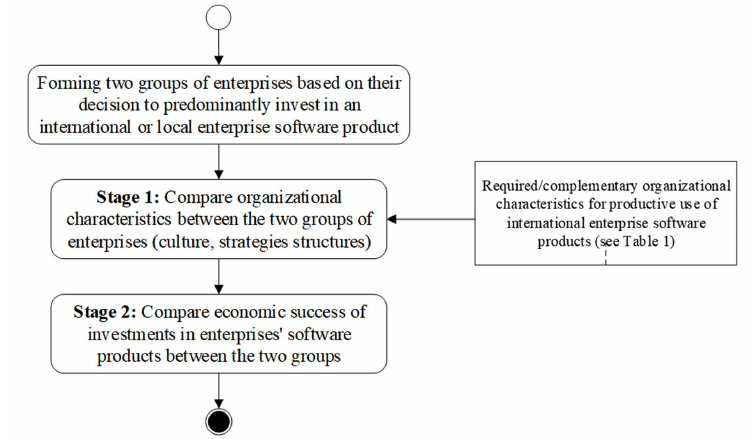
Figure 1. The proposed approach for evaluation of the success of the investments in enterprise software products (ERP, CRM,